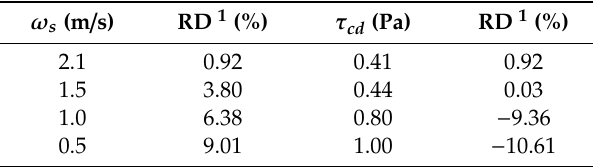
Table 5. Settling velocity ( ω s ) and critical shear stress for deposition ( τ cd ) in numerical experiments and results.